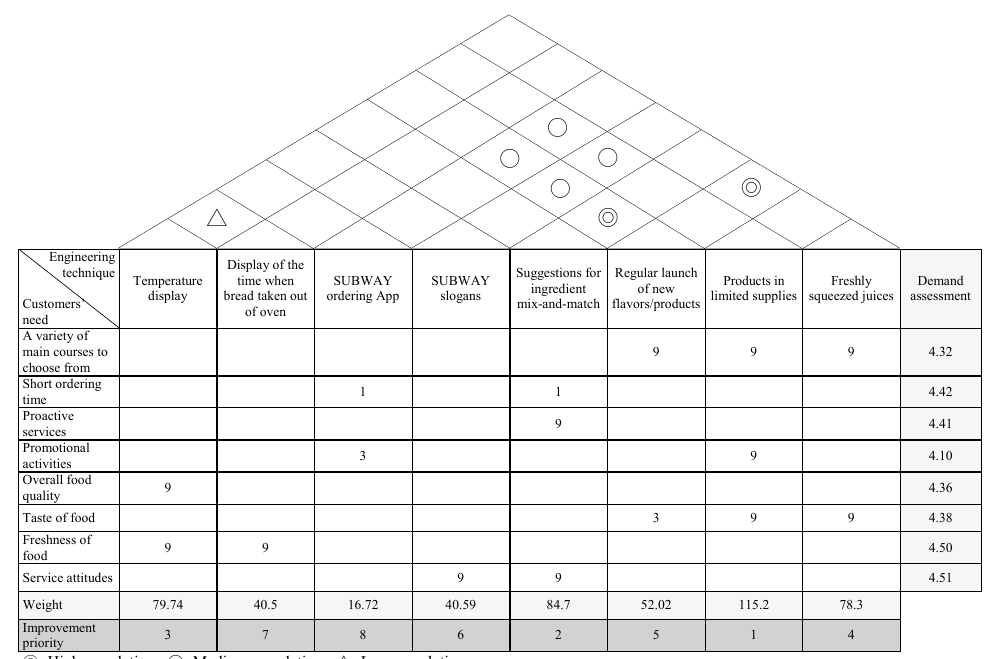
Figure 3. The house of quality for Subway.